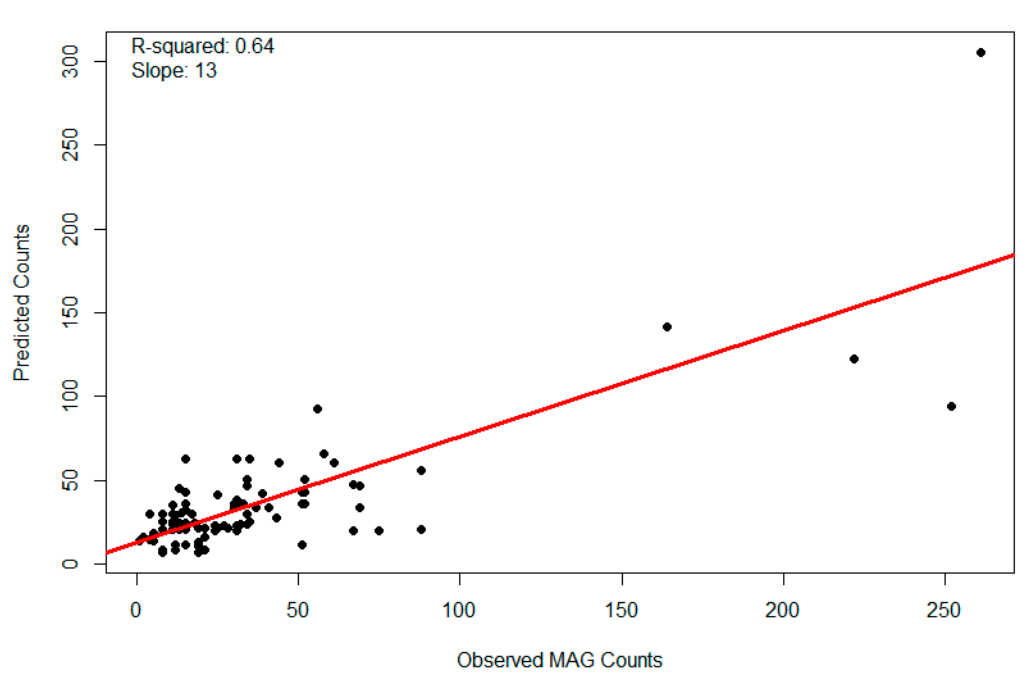
Figure 6. Poisson model predicted vs. actual AADB counts for Maricopa County (2016).